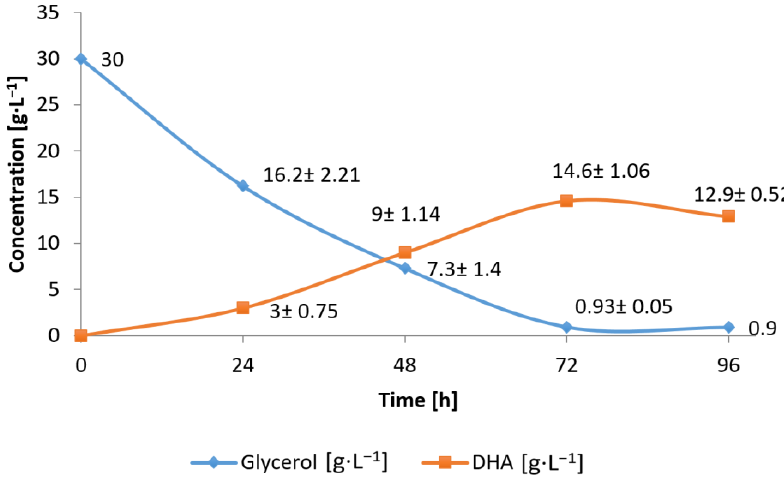
Figure 3. Time profiles of glycerol conversion and DHA formation during biotransformation of 30 g·L −1 waste g l ycerol with immobilized G. oxydans cells